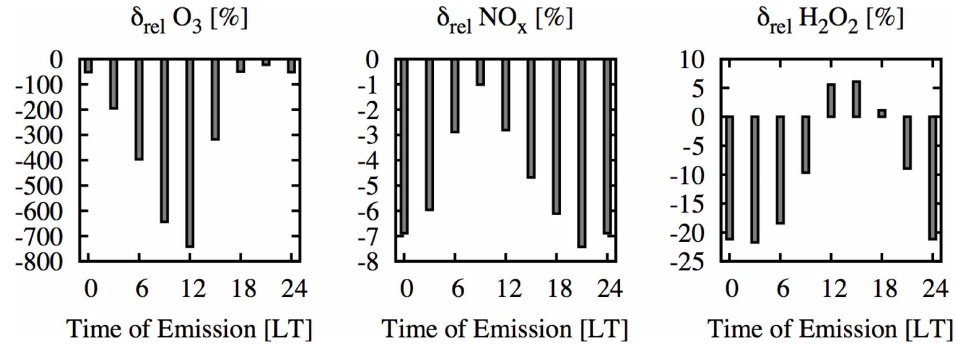
Fig. 11. Corrections of key species emissions (relative to NO x emissions) for the calcultion of EEI from ships (Franke et al., 2008).